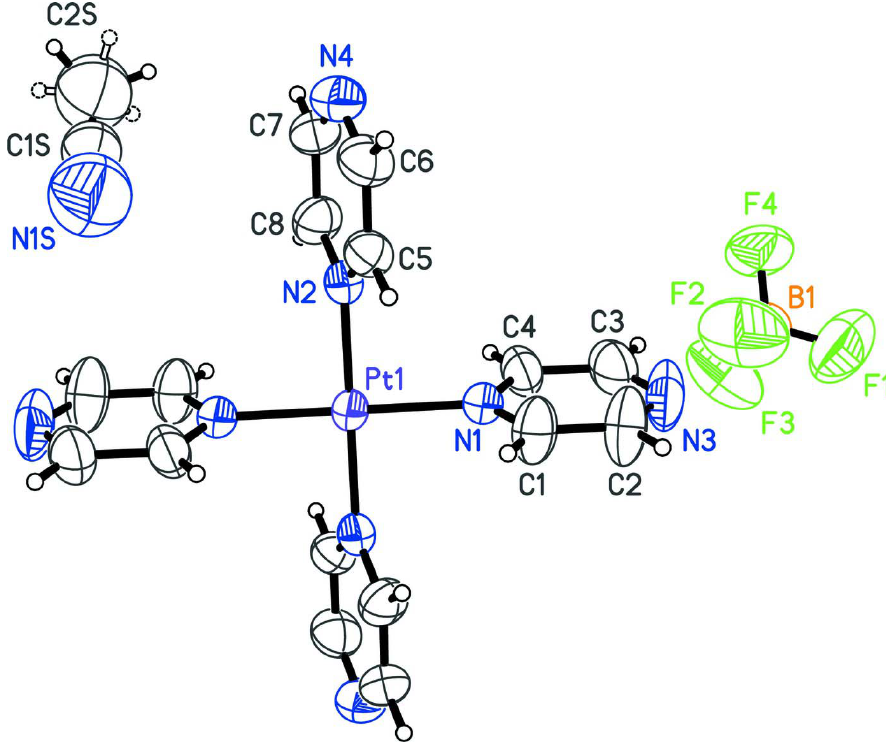
Ellipsoid plot of tetrapyrazineplatinum(II) tetrafluoroborate. Unlabelled atoms are generated via inversion through Pt1, symmetry code: - x , - y + 1, - z (50% probability displacement